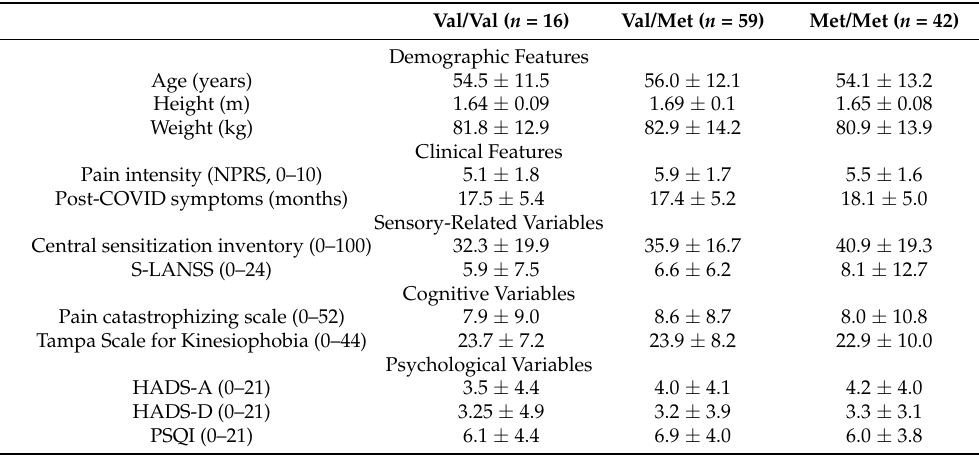
Table 4. Differences in clinical, sensory-related, cognitive and psychological variables in subjects with post-COVID pain depending on the catechol-O-methyltransferase gene ( COMT ) Val158Met polymorphism ( rs4680 ).